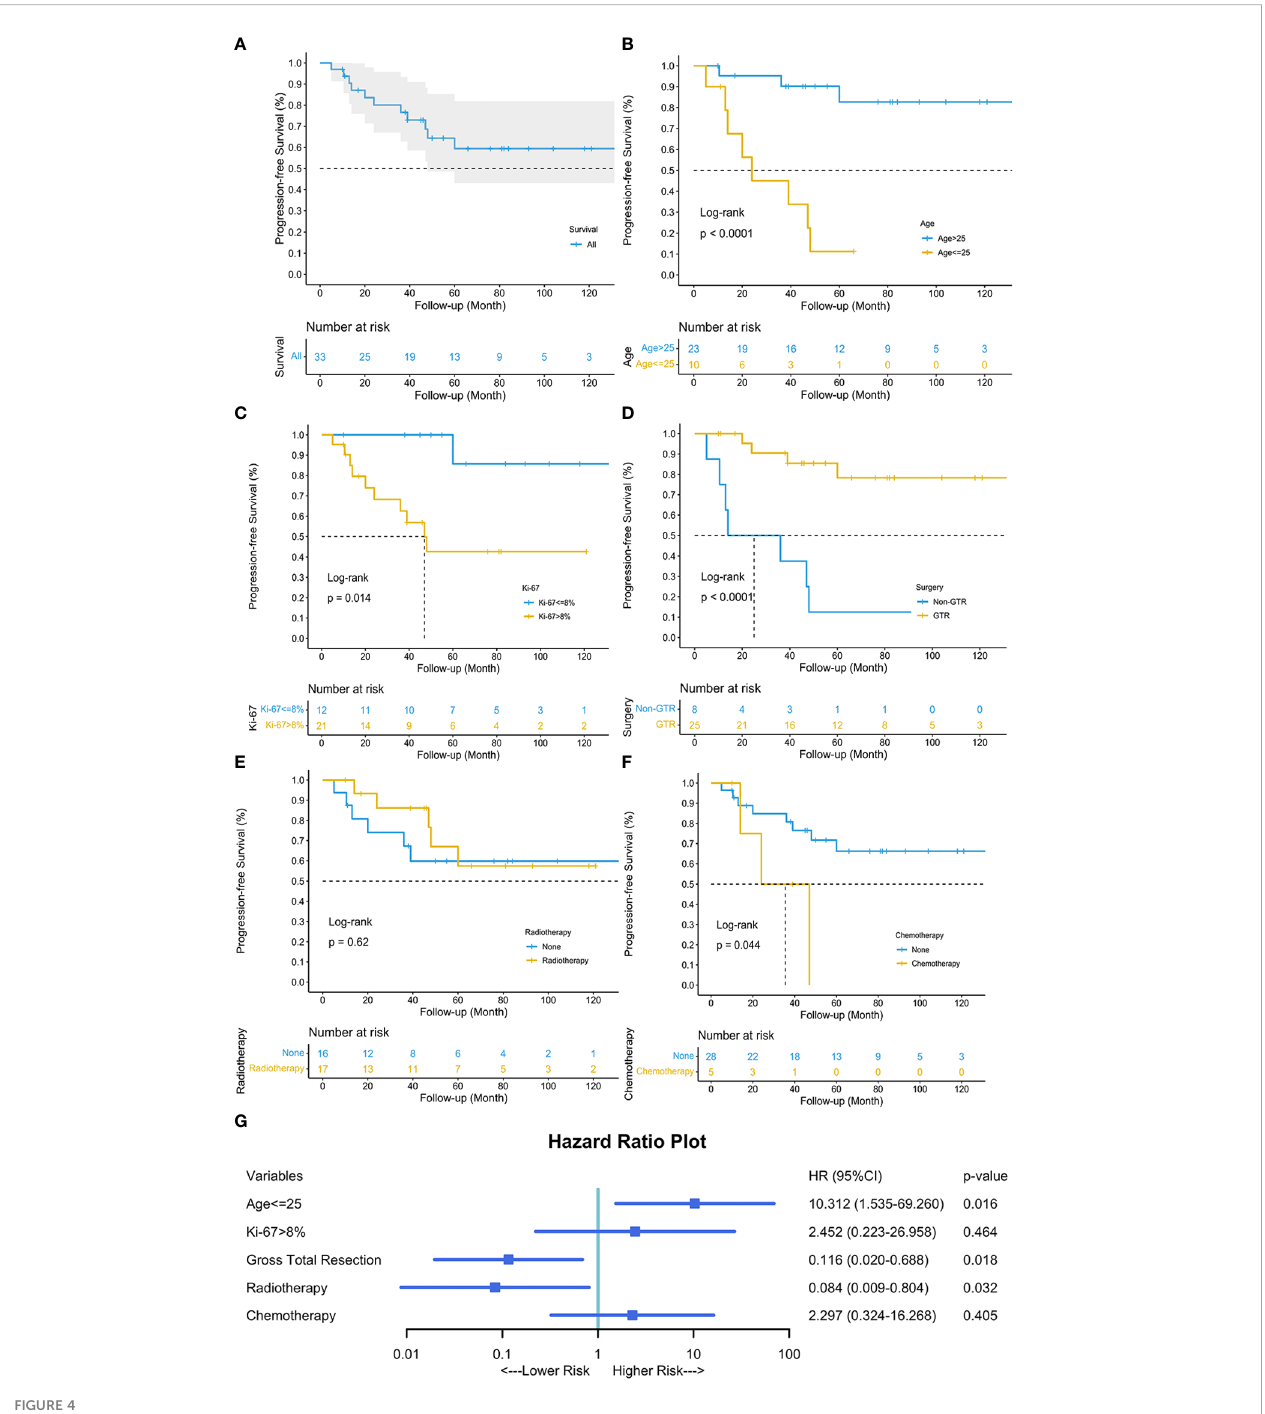
FIGURE 4 Kaplan-Meier curve depicted the progression-free survival of our 38 patients (A) . Univariable survival analyses of age (B) , Ki-67 (C) , surgery (D) , radiotherapy (E) , and chemotherapy (F) were visualized, respectively. Multivariable Cox Regression analysis revealed that age less than or equal to 25, GTR and adjuvant radiotherapy were three independent prognostic factors for tumor progression (G) . Blue square indicated the hazard ratio (HR) values, and error bars revealed the 95% con fi dence